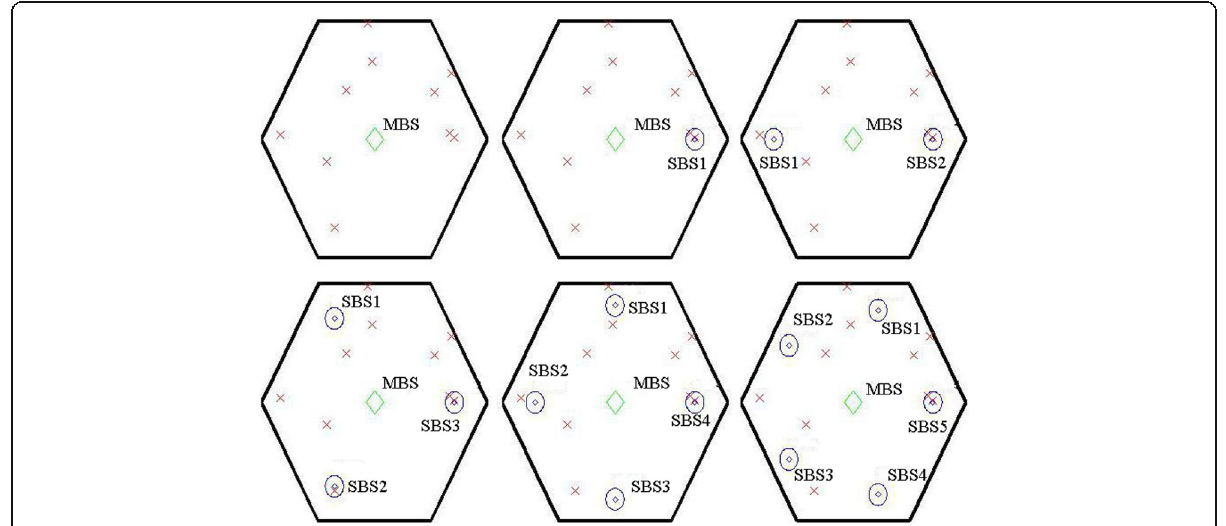
Fig. 2 Simulation model under different cooperation schemes. ◇ represents macro base station. о represents small base station. × represents user